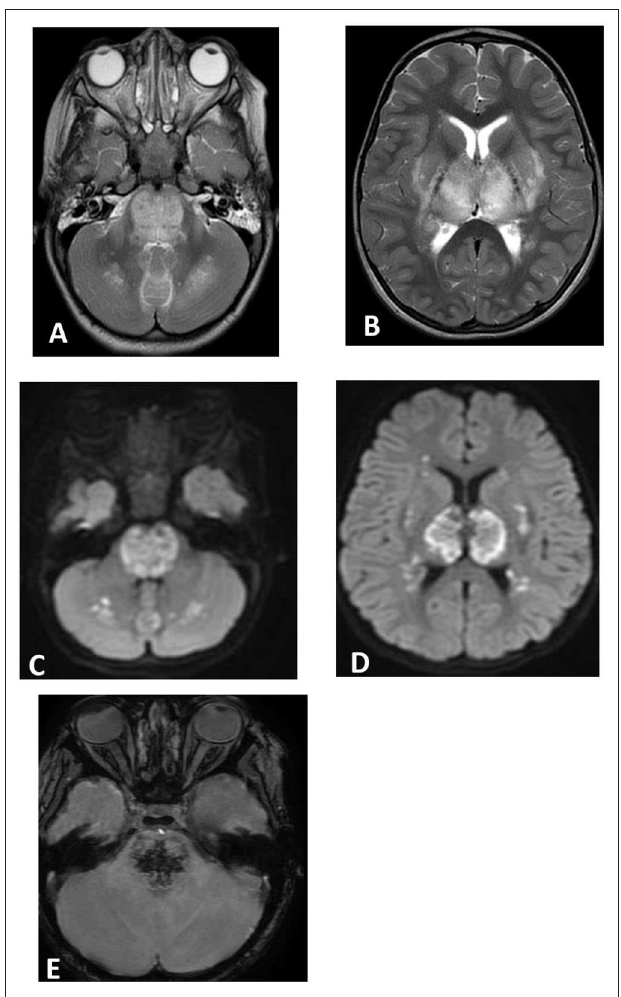
FIGURE 2 | Brain MRI. Axial T2 (A,B) , diffusion (C,D) , and susceptibility (E) weighted images. There are swelling and abnormal high signal intensity of pons, bilateral cerebellar white matter (A) , both thalami, and bilateral putamen (B) with diffusion restriction (C,D) and dark signal intensity with blooming in the pons (E)